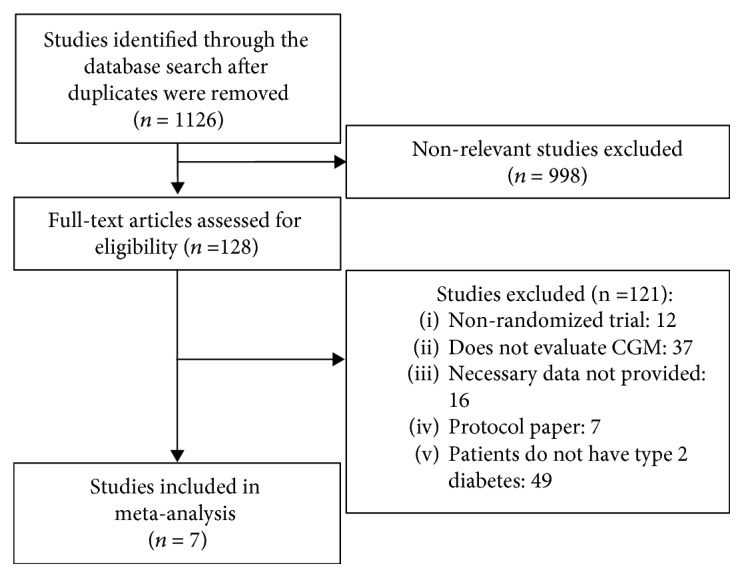
Study flow diagram.